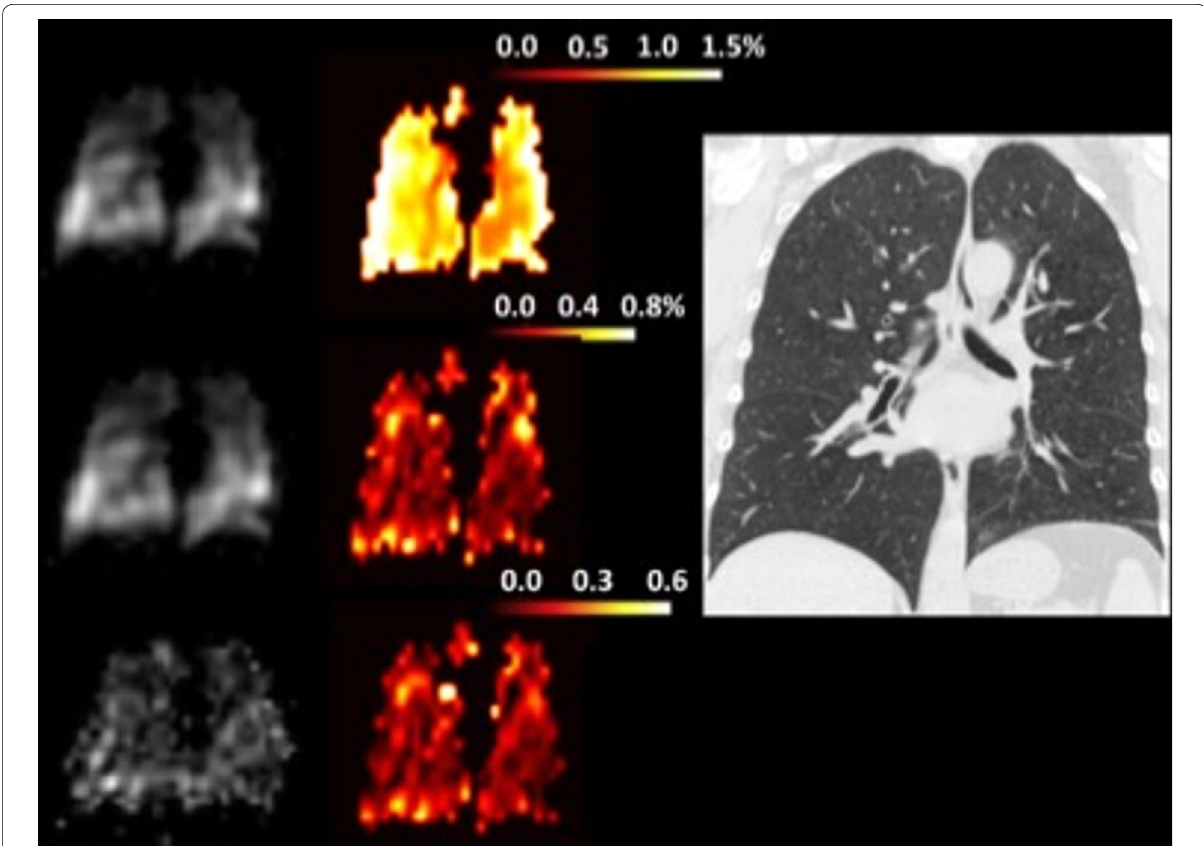
Fig. 2 High resolution CT and hyperpolarized 129 Xe dissolved-phase MR images in patient with COPD. In order, image reconstructions of gas (top left), tissue (left middle) and red blood cells (bottom left) compartments are presented. The paired color gradient images are fused reconstructions demonstrating relative gas content in the different compartment; tissue/gas, RBC/gas and RBC/tissue. Adapted from [16] with